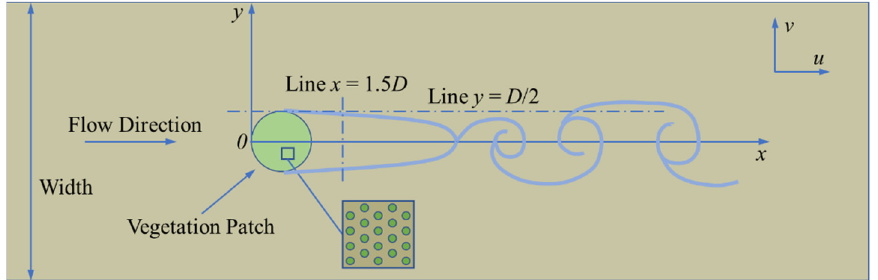
Figure 1. Top view of the numerical simulation arrangement. An emerged vegetation patch is arranged at the central line of a rectangular channel.